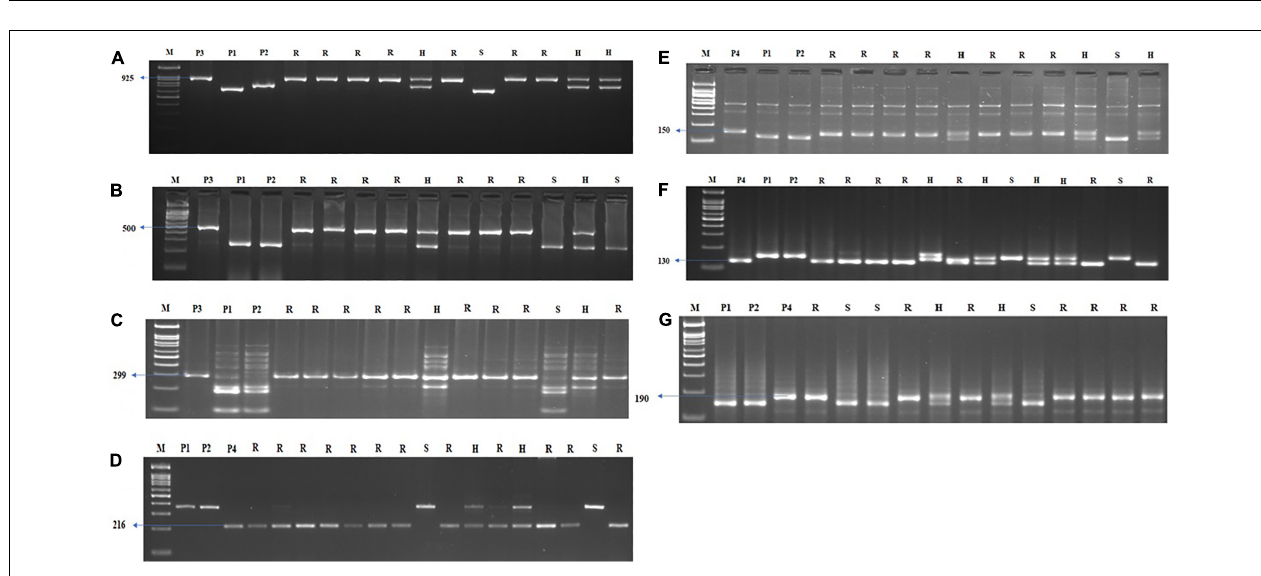
FIGURE 5 | Agarose gel electrophoresis images illustrating the presence of (A) Xa21 , (B) xa13 , (C) xa5 , (D) Pi54 , (E) qSBR11-2 , (F) qSBR11-I , and (G) qSBR7-1 alleles. P1 – ASD 16, P2 – ADT 43, P3 – IRBB60, P4 – Tetep, M – 100-bp ladder, R, resistant; H, heterozygote; S,